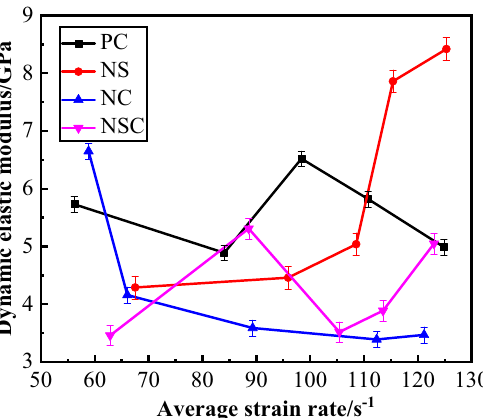
Figure 15. Relationship between dynamic elastic modulus and average strain rate of concrete.